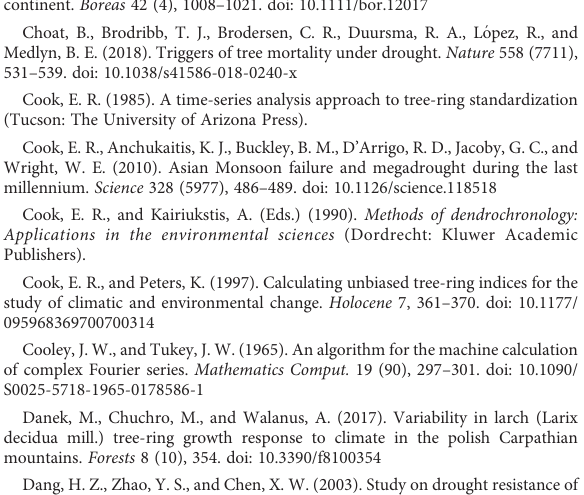
SUPPLEMENTARY FIGURE 2 Statistical comparison of the raw tree-ring measurements at the fi ve sampling sites (alighed by elevation).